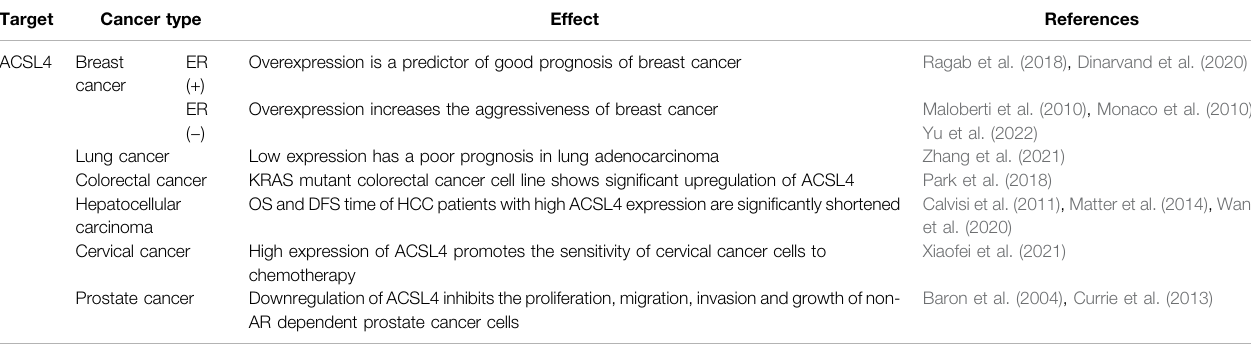
TABLE 1 | Impact of ACSL4 expression in different cancer